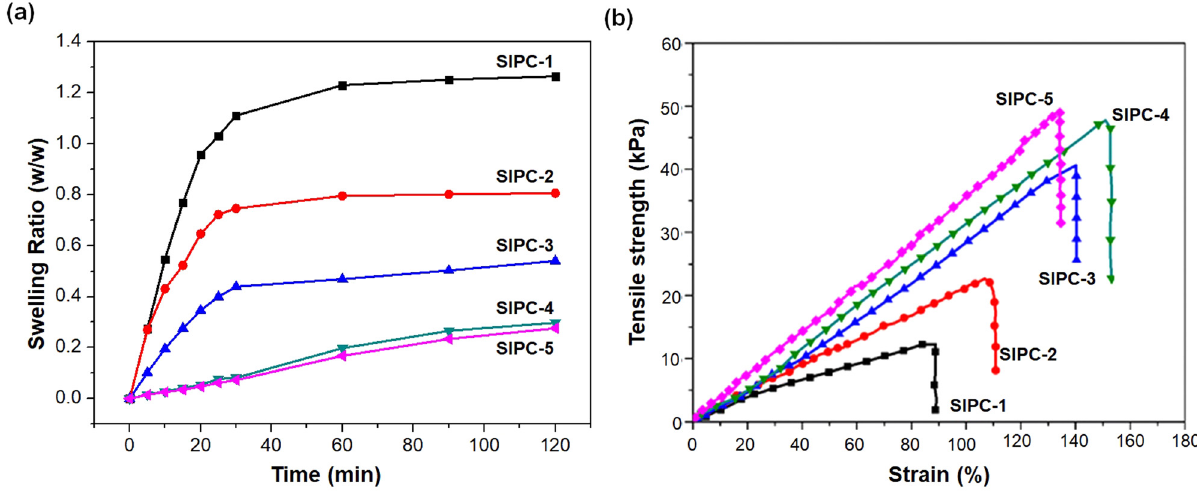
Figure 5: ( a ) Swelling ratio versus time and ( b ) the tensile stress – strain curves of the SIPC